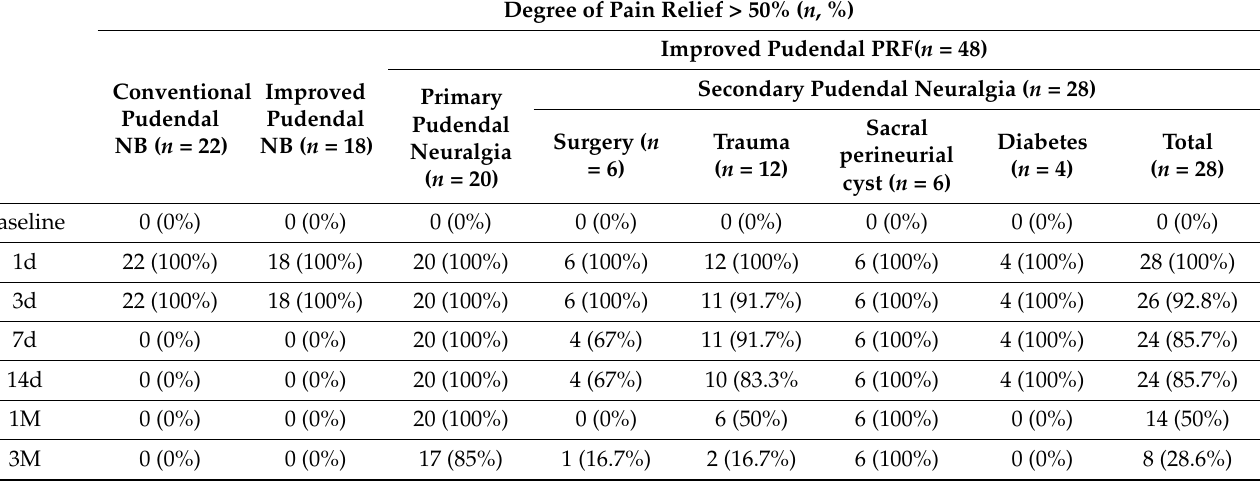
Table 6. Numerical statistics in degree of pain relief (>50%) from baselines (pretreatment) to post treatment (1d, 3d, 7d, 14d, 1M, 3M) in pudendal neuralgia. Degree of Pain Relief > 50% ( n ,